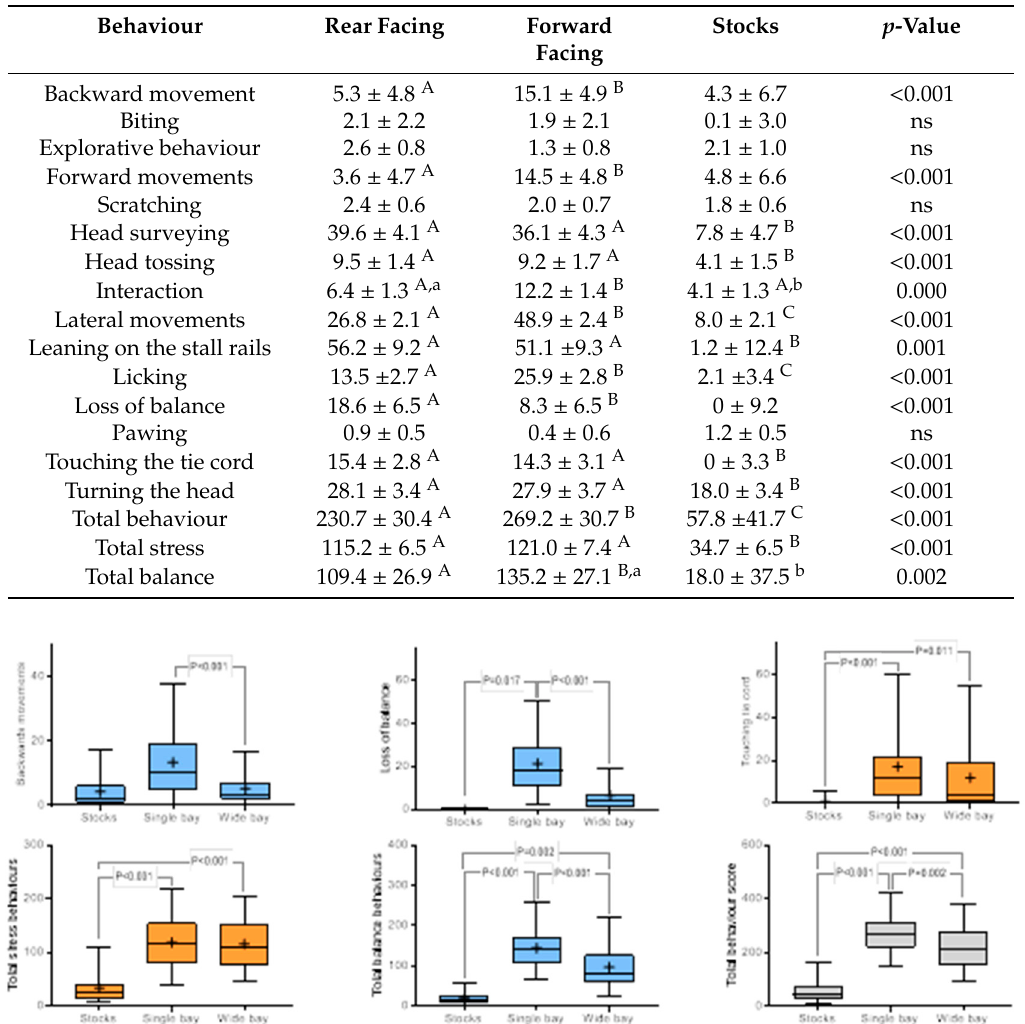
Figure 4. E ff ect of space (stocks, single or wide bays) on key behavioural characteristics. Results are shown as mean ( + ) and median (horizontal line), quartile (box) and 95% confidence interval (whiskers), with significant di ff erences between groups shown. Balance-related behaviours are blue, stress-related behaviours are orange, total behaviours are shown in grey.